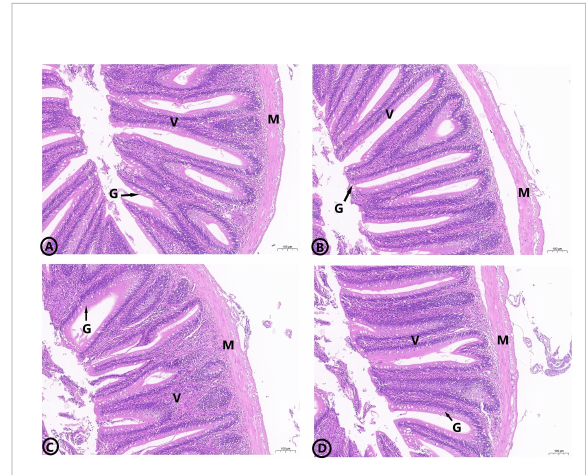
FIGURE 9 Effects of dietary MOS on the histological structure of Intestinal of the common carp under ammonia stress for 30 days. Bar = 100 m m, H&E Staining, 10.00X. Control group (A) , ammonia group (B) , MOS group (C) , and MOS/Am group (D) . M, Muscular; V, Villi; G, Goblet